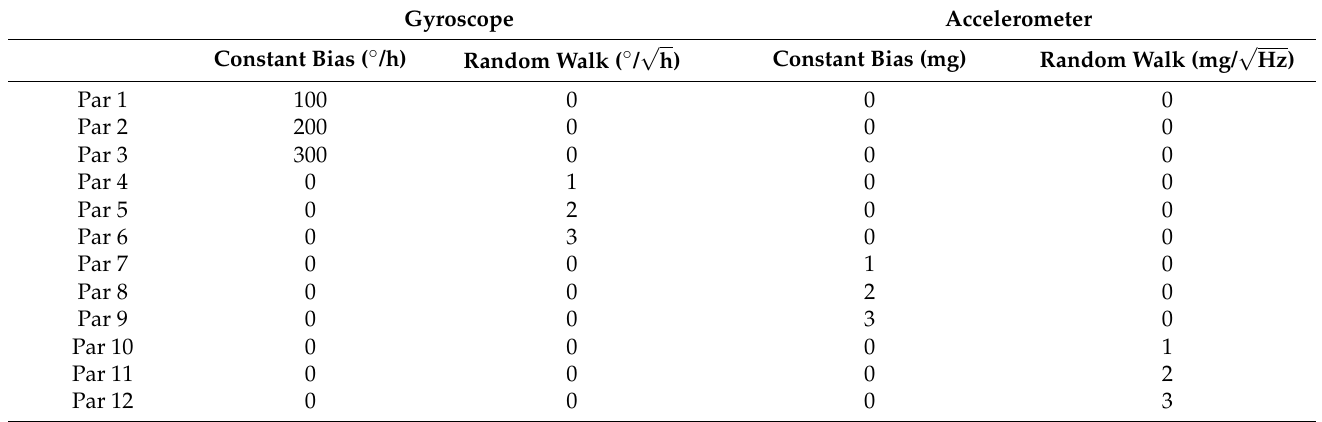
Table 2. Error parameters to be